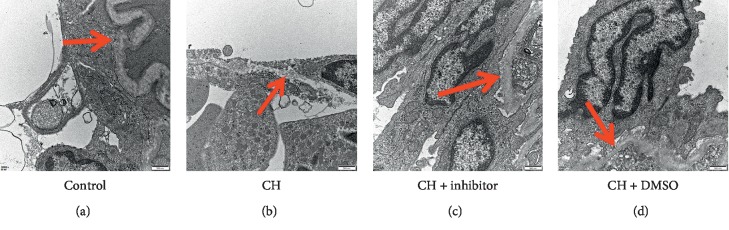
Ultrastructural analyses of BM. Photomicrographs of BM of one randomly selected slide per group. Scale bar = 500 nm. BM degradation was higher in the CH group compared to that in the control group. Treatment with an STAT3 inhibitor significantly decreased BM degradation. Control: control group; CH: chronic hypoxia group; CH + inhibitor group: chronic hypoxia + STAT3 inhibitor; and CH + DMSO group. Red arrows indicate the BM of microvessels. (a) Control. (b) CH. (c) CH + inhibitor. (d) CH + DMSO.